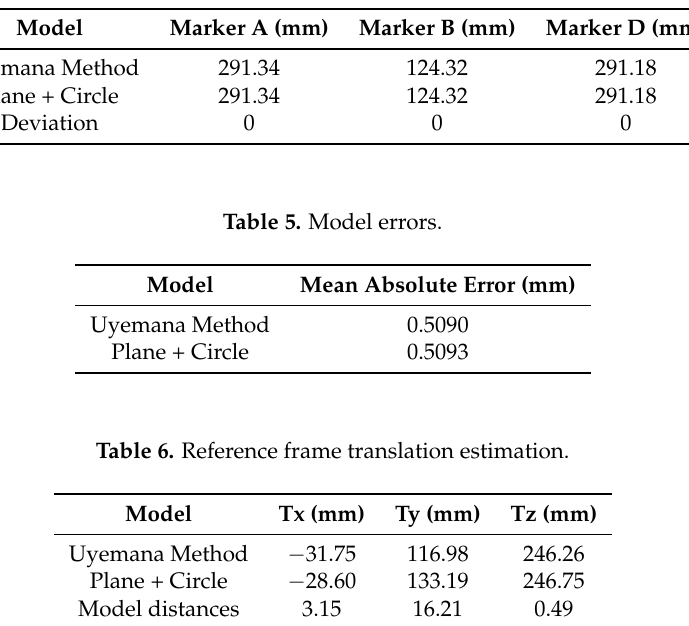
Table 4. Marker radial position.